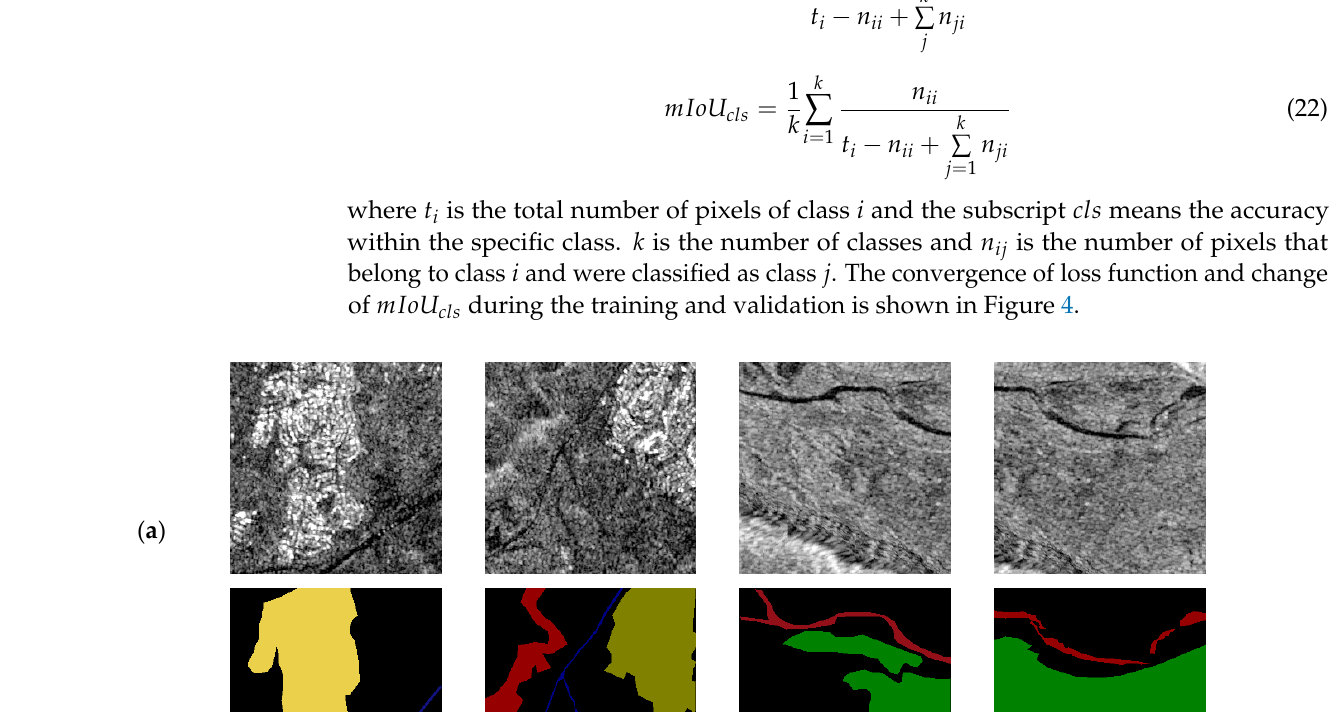
( a ) The convergence of loss function ( b ) The change of mIoU cls